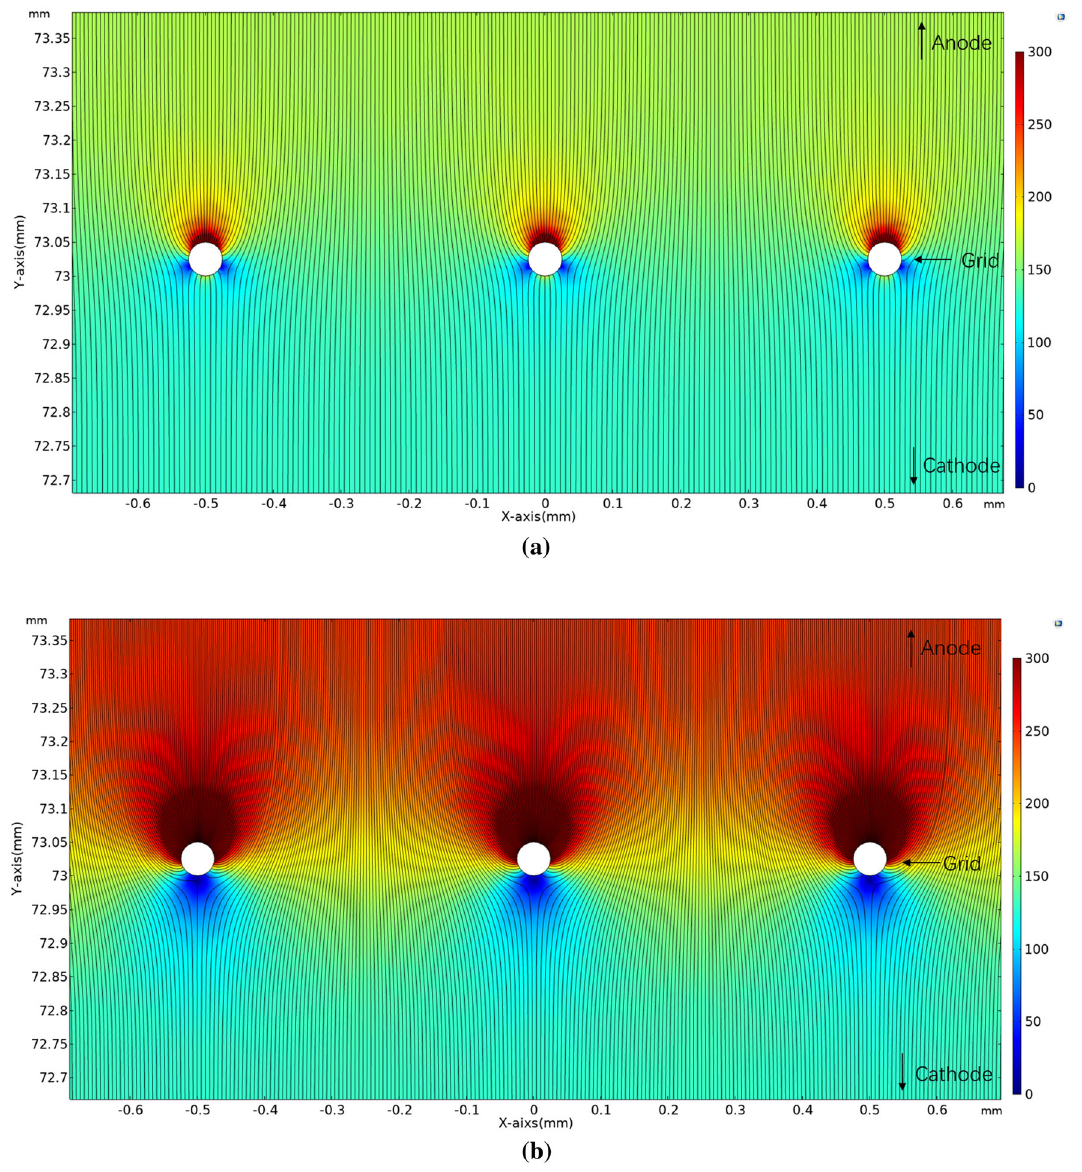
Fig. 6 The Graph on the top a shows the distribution of the electric field lines around the grid wires for a voltage setting of R < R min , and on the bottom b is for the case of R ≥ R min the parallel-wire and mesh grids exhibit a similar optimal energy resolution of about 0.85% after reaching 100% elec- tron